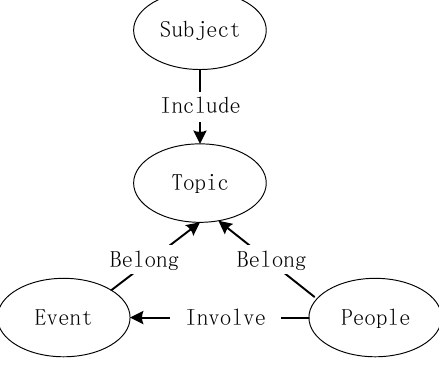
Figure 10. Entity, relation model diagram.